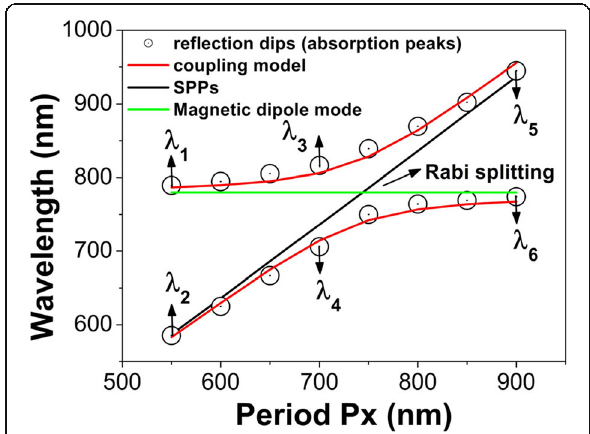
Fig. 3 Open black circles show the positions of absorption peaks or reflection dips in Fig. 2, and two red curved lines give the corresponding positions predicted by the coupling model of SPPs and MD mode. The resonance wavelengths of SPPs (black diagonal line) and MD mode (horizontal green line) are also